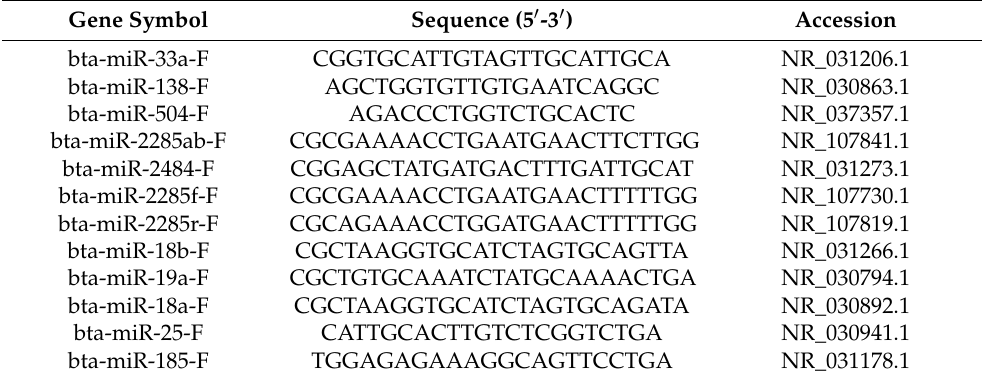
Table 1. List of the primers used in this